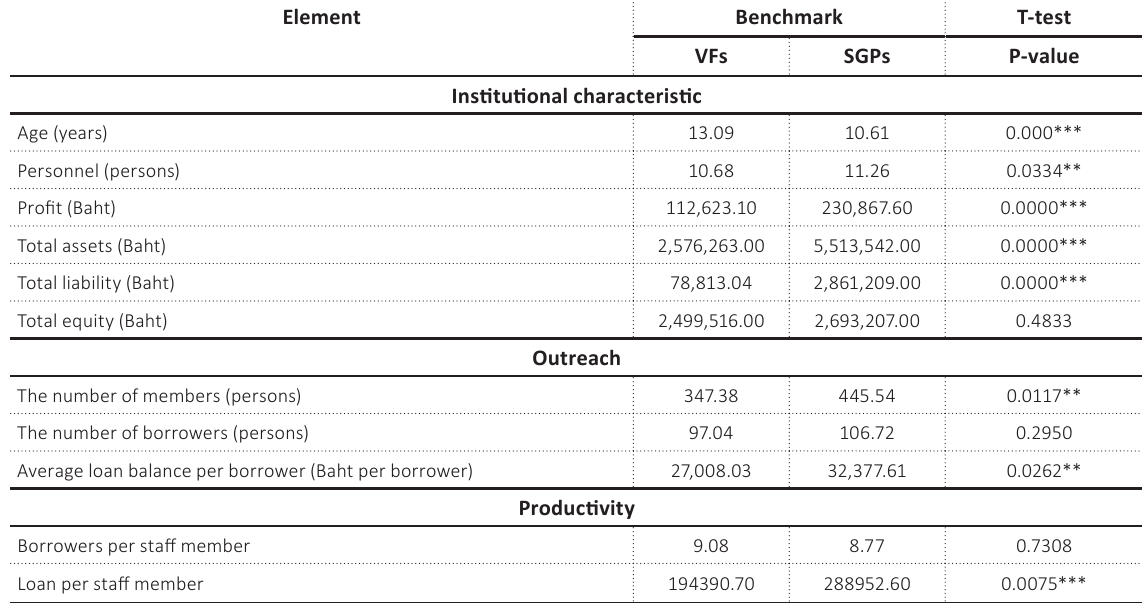
Table 2. Institutional characteristics, outreach and productivity of Thai VFs and SGPs (mean values from 2014 to